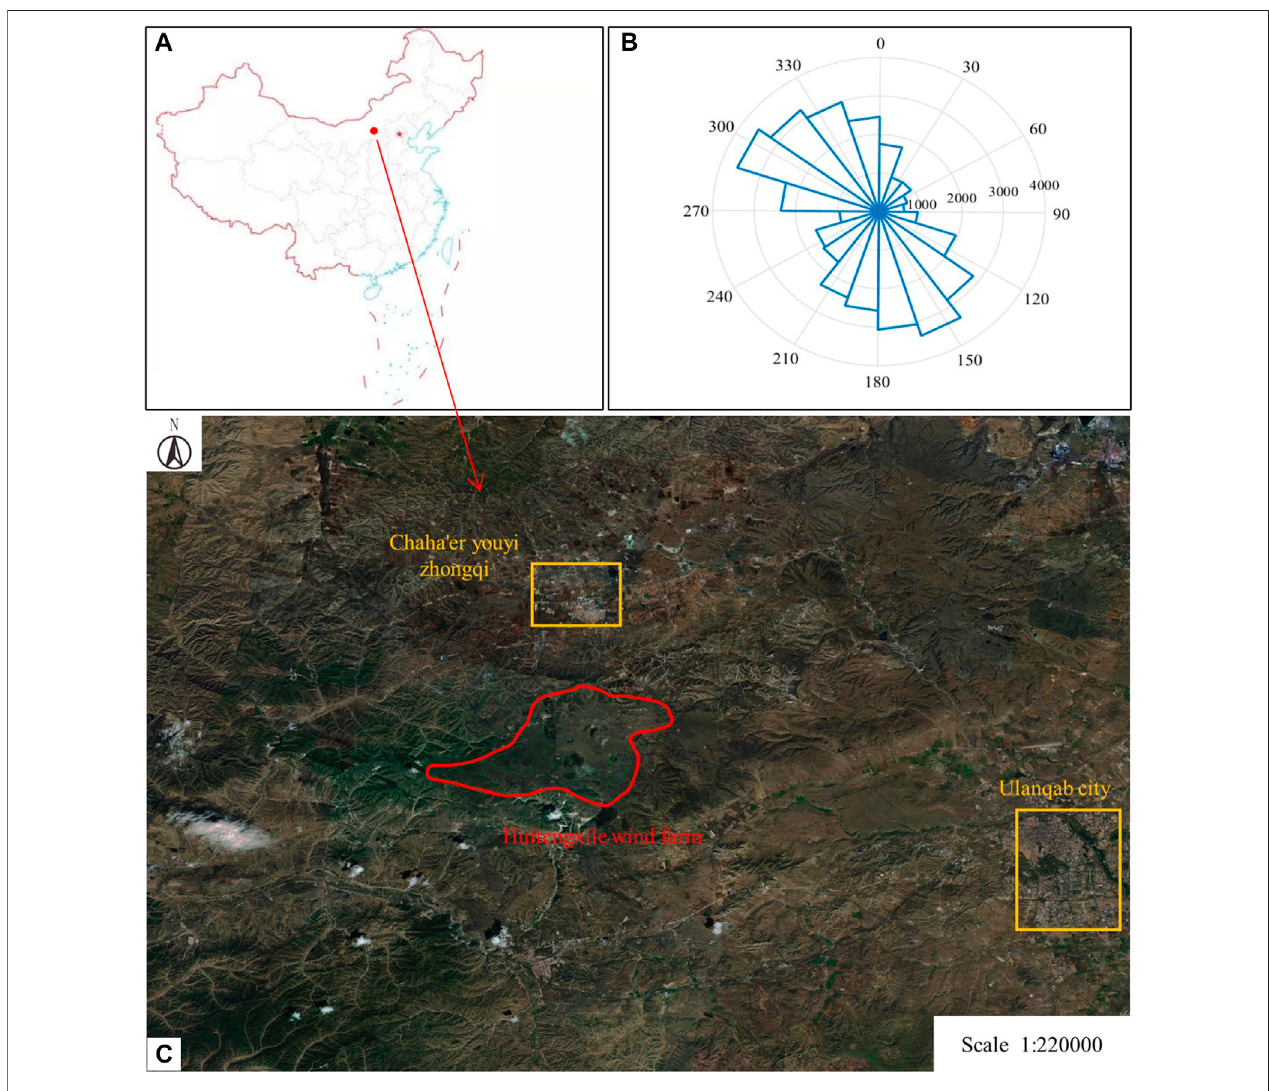
FIGURE 1 | Location of the Huitengxile wind